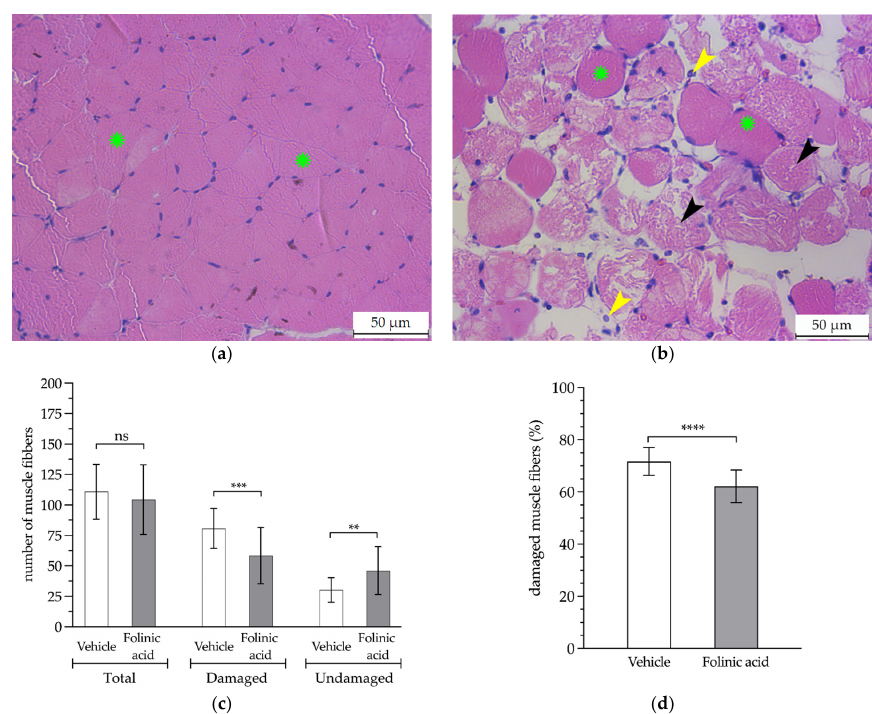
Table 2. Rotarod test values. The table represents the mean time in seconds (s) and the standard deviation for the time that untreated (vehicle) or treated (folinic acid, FA) animals remained walking on the rod. The p value indicates the statistical significance between the vehicle group and the FA- treated group (ns: p > 0.05). Figure 5. Microscopic analysis of the damage to the gastrocnemius muscle. Histological sections of the gastrocnemius muscle of both the contralateral healthy ( a ) and non-treated ischemic lower limbs ( b ), showing the non-damaged muscle fibers (green asterisk), the damaged muscle fibers due to the ischemia process (black arrowhead), and the inflammatory infiltrate of the polymorphonuclear cells (yellow arrowhead). The count of the total number of muscle fibers, damaged and undamaged ( c ), and the percentage of damaged fibers relative to the total number of fibers ( d ) for each histological section analyzed at a 66× magnification (**: p < 0.01; ***: p < 0.001; ****: p < 0.0001; ns: p > 0.05).